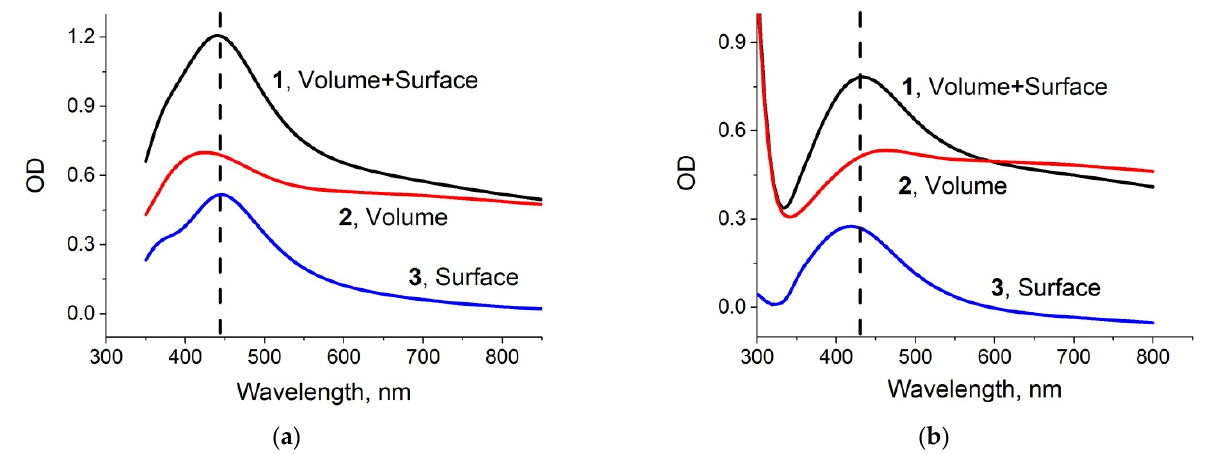
Figure 3. Optical absorption spectra of the prepared samples before ( a ) and after ( b ) 1 day exposure to PBS. 1–spectrum of the sample, 2–spectrum of the sample after removal of NPs from the surface (“volume” NPs spectrum), 3–residual spectrum (“surface” NPs spectrum).